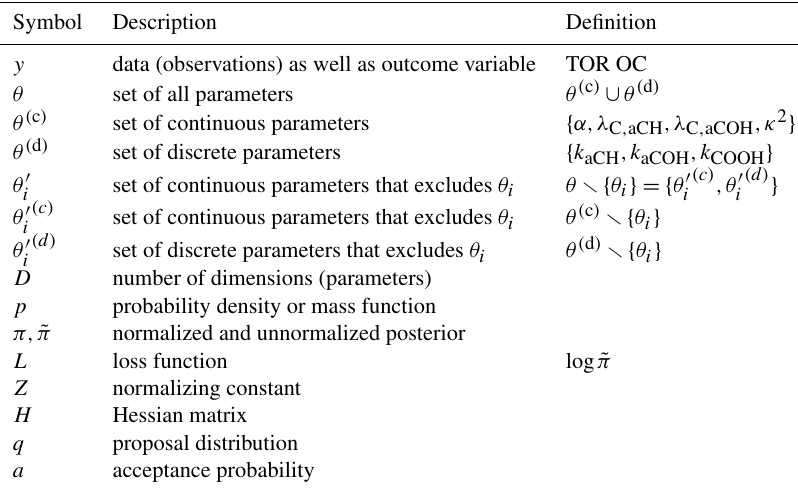
Table A2. Notation for Bayes theorem, likelihood, and posterior sampling